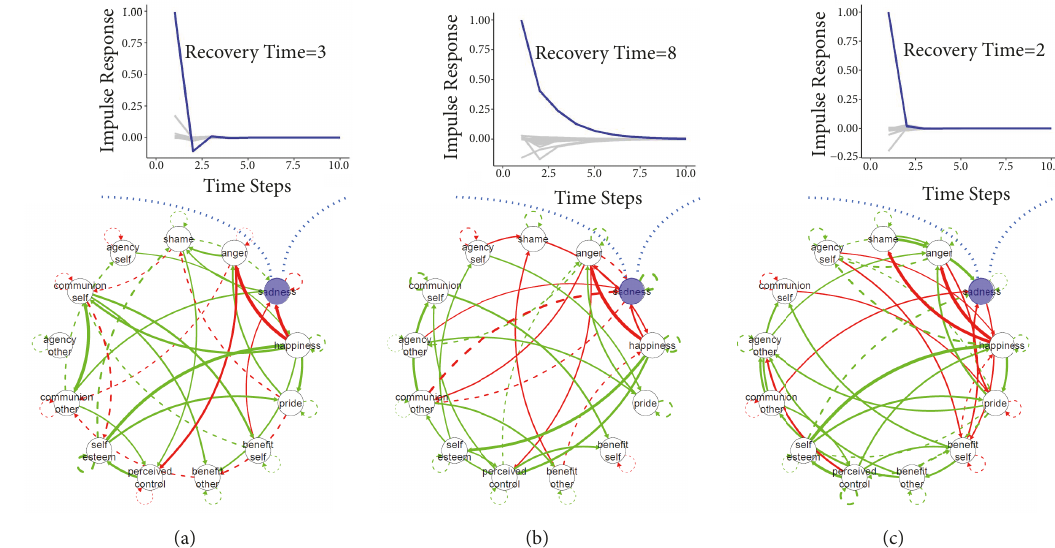
Figure 3: Illustration of change in network structure and recovery time across the three bursts ((a), (b), and (c), respectively) for one individual. Corresponding recovery times were k 1 = 3, k 2 = 8, and k 3 =2,